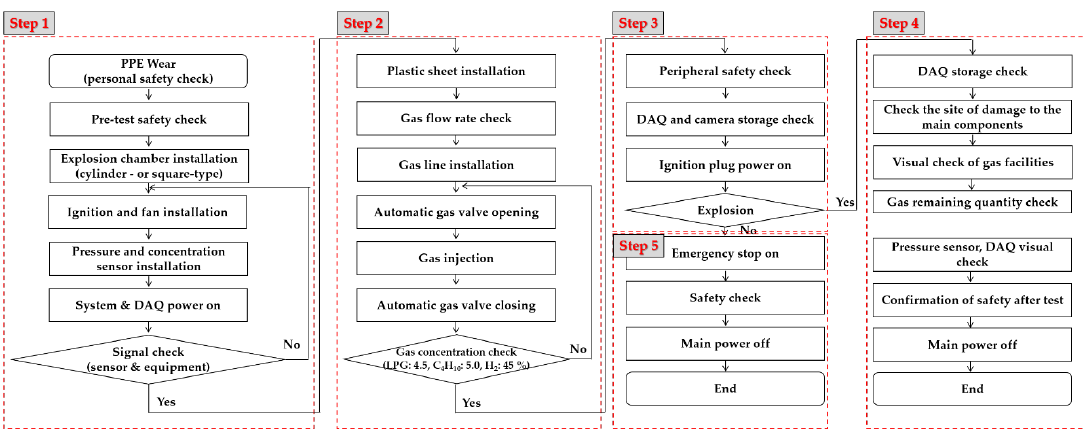
Figure 7. Flow chart of explosion test.